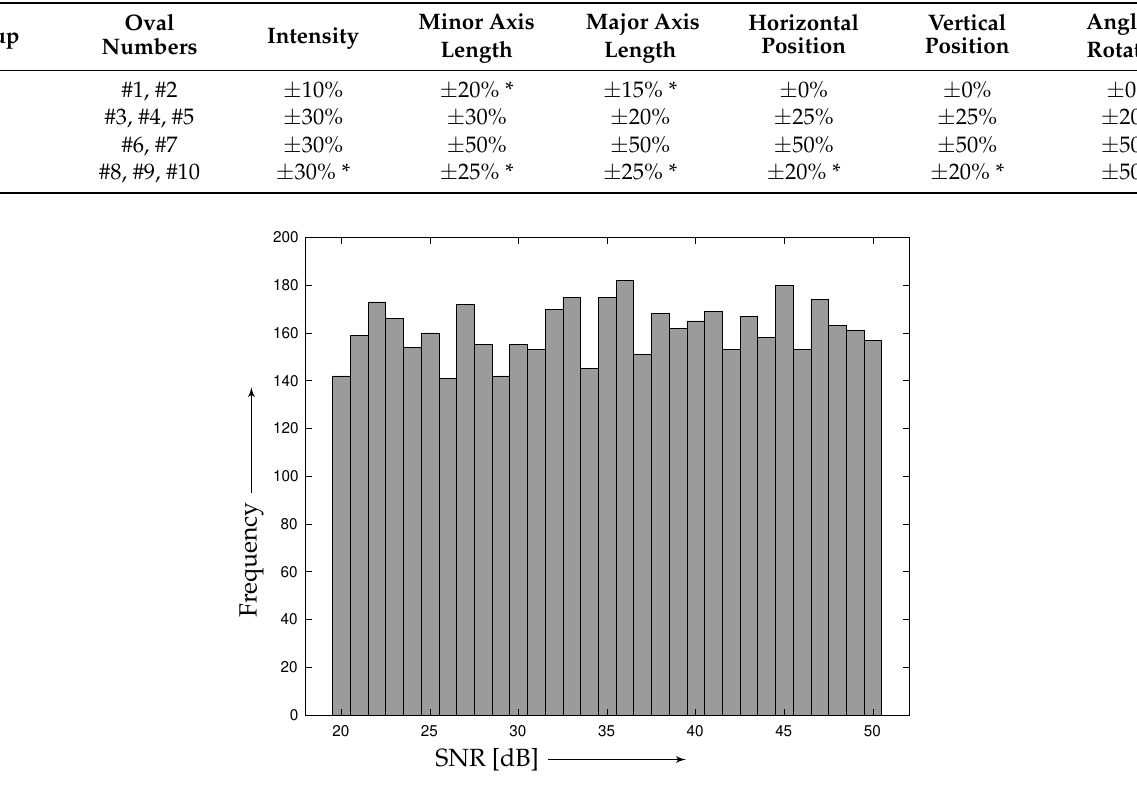
Figure 5. Histogram of projection SNRs in input data